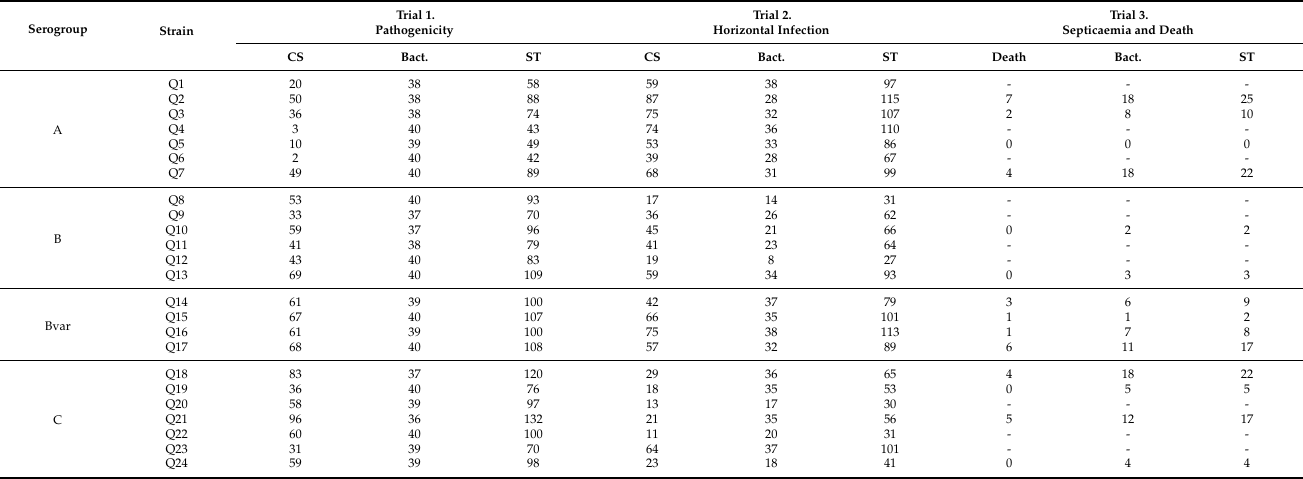
Table 1. Trials 1, 2, and 3. Summary of clinical signs scores, re-isolation rates of Avibacterium paragallinarum from infraorbital sinuses (Trials 1 and 2) or livers (Trial 3), and death caused after intraperitoneal inoculations (Trial 3). In Trial 3, only the most pathogenic strains from Trials 1 and 2 were tested. More detailed results are available in Tables